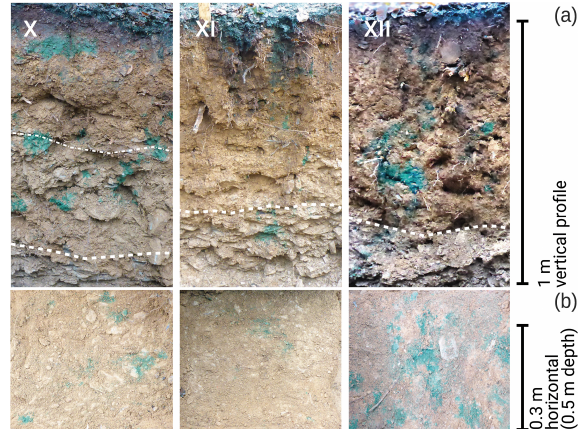
Figure 6. Recovered dye patterns in plot irrigation experiments. (a) Excavated vertical faces, (b) horizontal cuts in 0.5m depth. Dashed lines indicate level of periglacial deposit